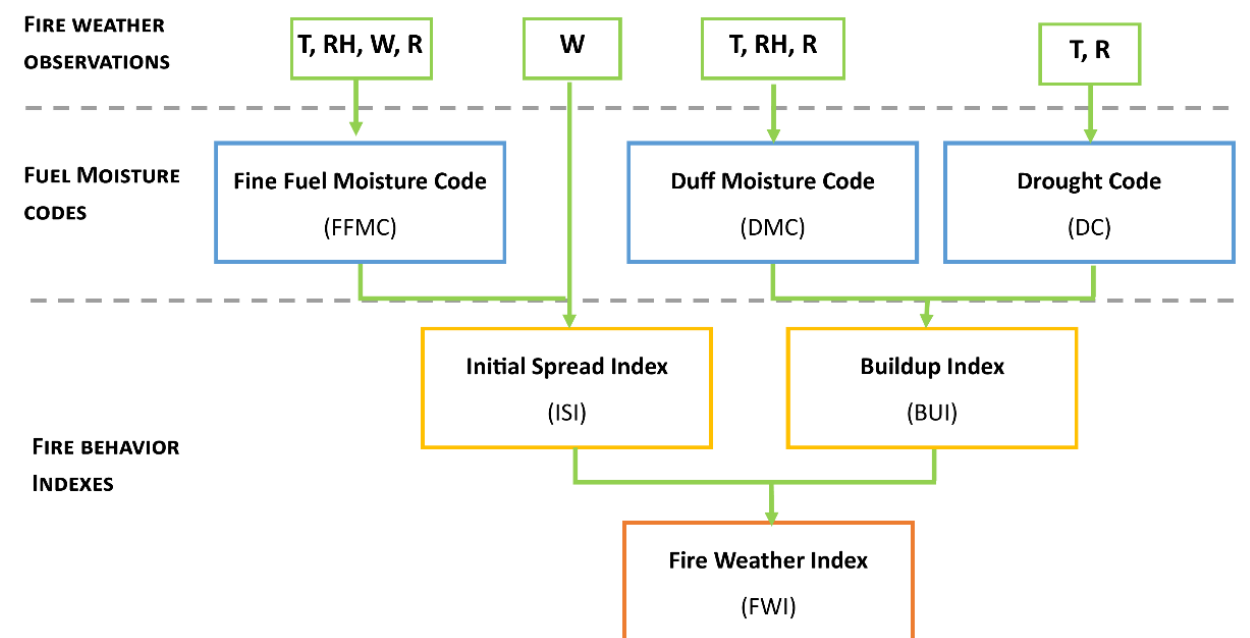
Figure A2. Fire weather schematics in which T (°C) is the air temperature, RH (%) is the relative humidity, W is the wind speed (km/h), and R (mm) is the rain (Adapted from Van Wagner [27]). Fire 2023 , 6 , x FOR PEER REVIEW